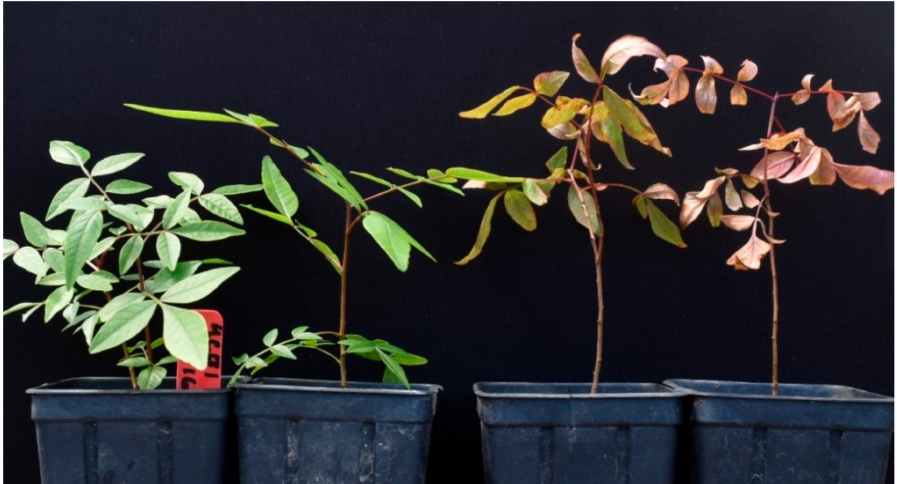
Figure 8. Symptoms produced on 4-month-old plantlets of clonal UCBI rootstocks after 22 days incubation and following root inoculation using a microsclerotia suspension with control plants (left) and inoculated plants